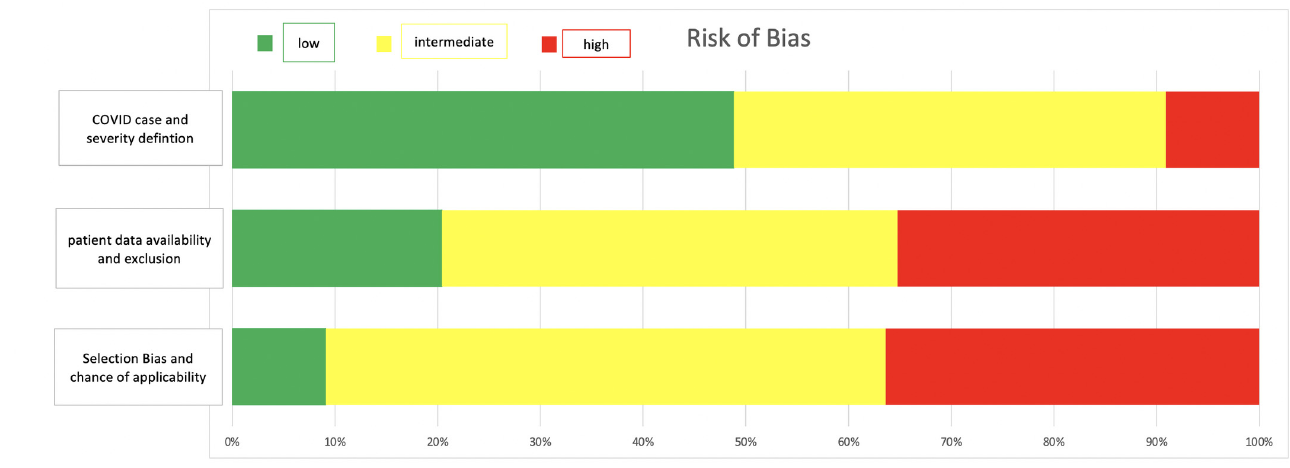
Fig 2. Risk of bias